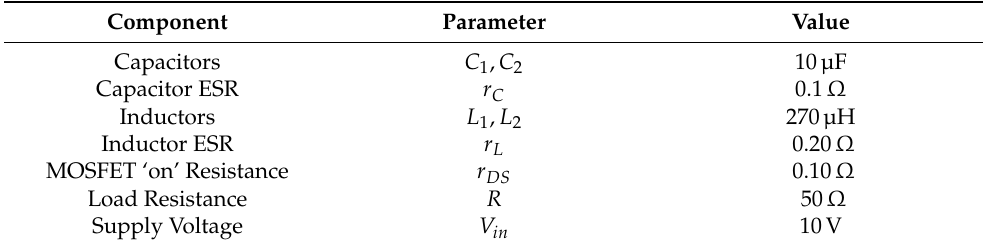
Figure 4. Boost inverter active operating modes for ( a ) S 1 = S 4 = 1, S 2 = S 3 = 0 and ( b ) S 1 = S 4 = 0, S 2 = S 3 = 1. Table 1. Sample boost inverter